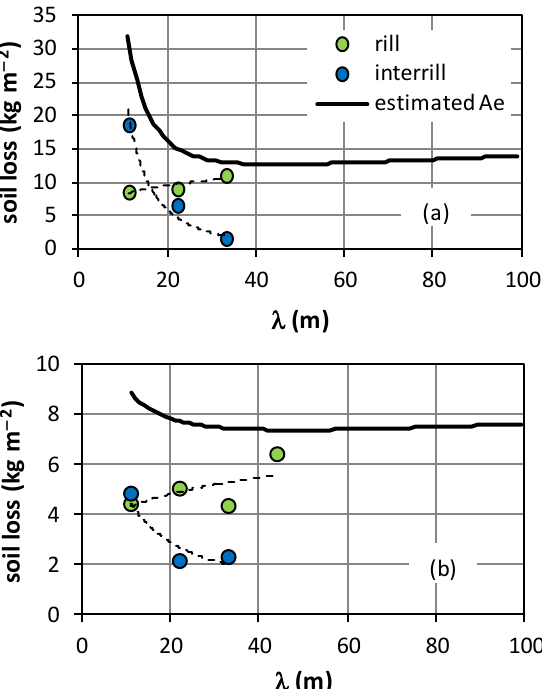
Figure 4. Relationship of total, A e , rill, and interrill soil loss vs. plot length, λ , for the ( a ) 1 September 2005 event and ( b ) 28 June 2008 event (modified from [28]).